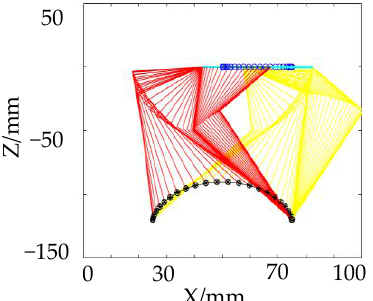
Figure 10. The optimized trajectory of a single leg in one gait cycle .